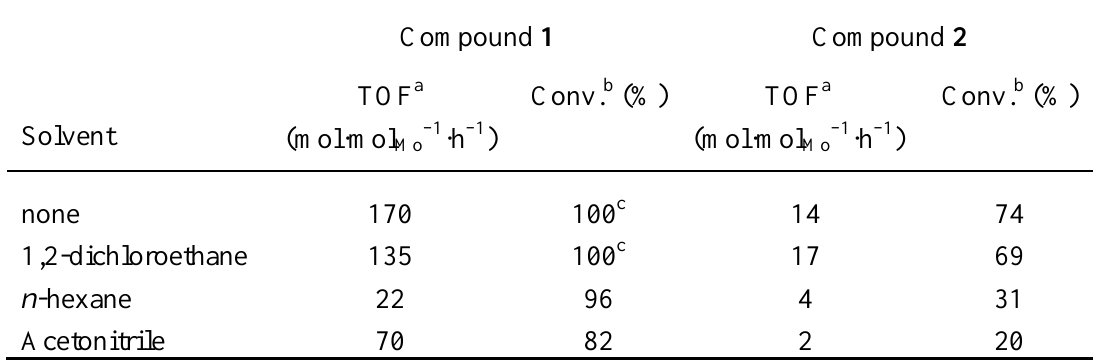
Table 2. Catalytic activity of compounds 1 and 2 for cyclooctene epoxidation at 55 ºC, using different